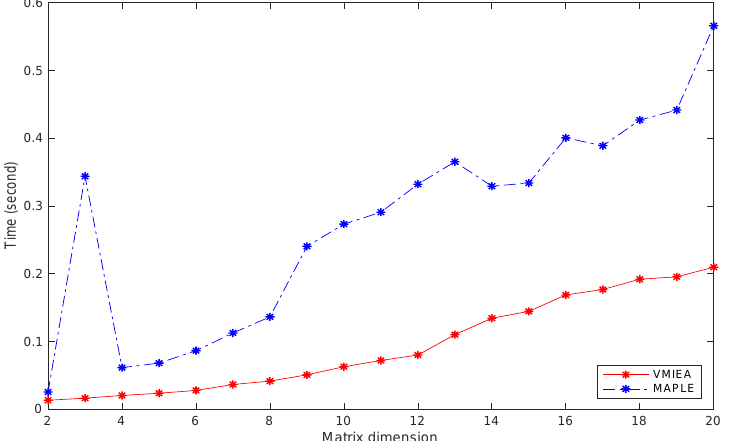
Figure 2. Running time for computing the inverse of numerical Vandermonde matrix V n ,0 ( 1,2, . . . , n ) via VMIEA algorithm (in red color) and Maple inversion function for matrices (in blue